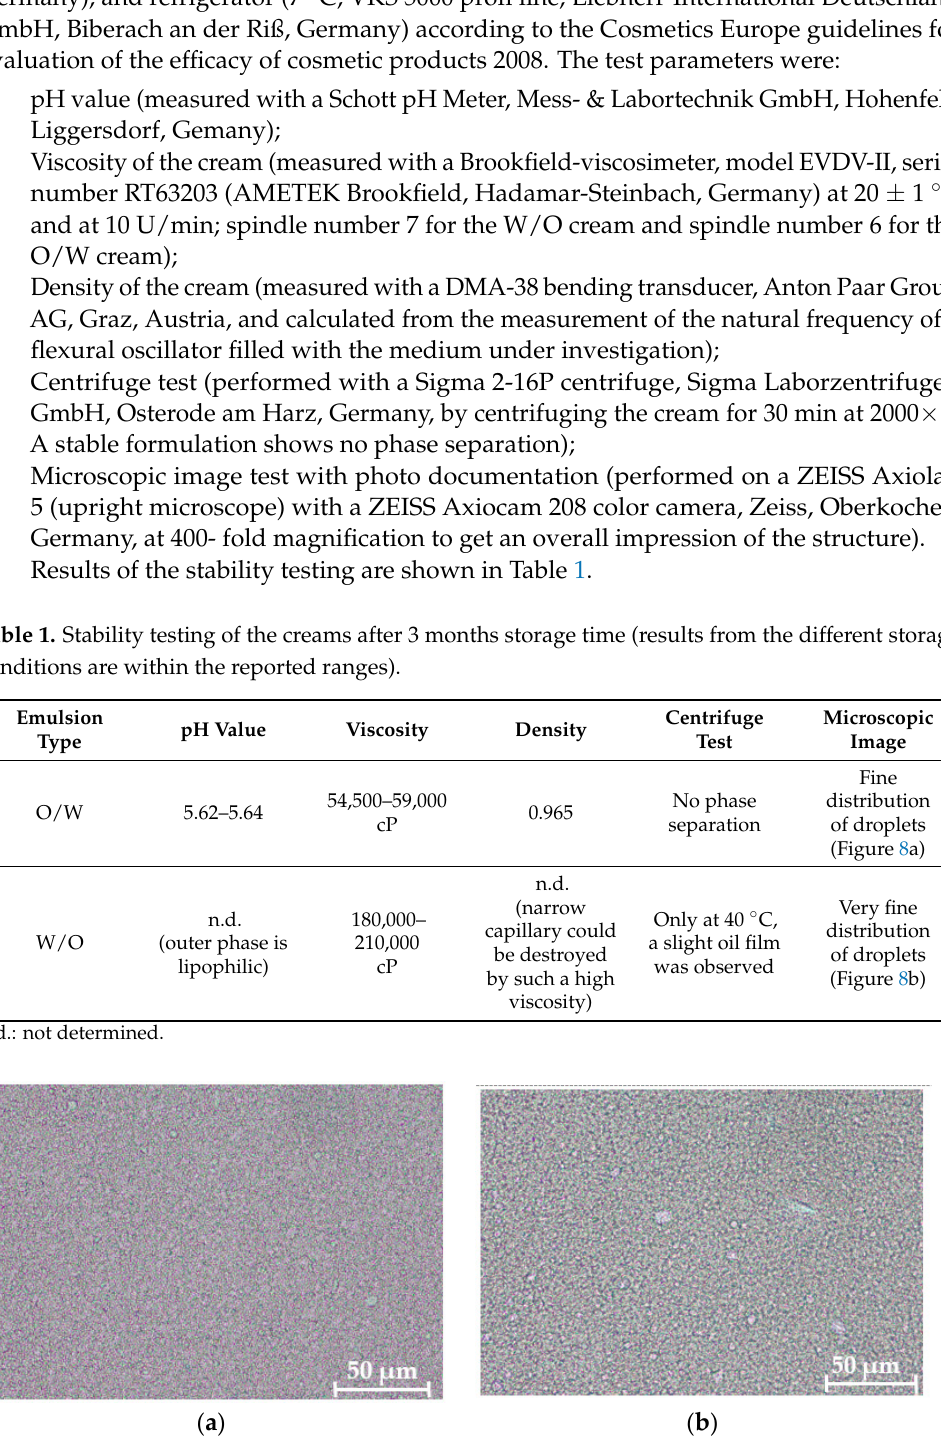
Figure 8. Microscopic images of the O/W ( a ) and W/O ( b ) cream at a magnification of